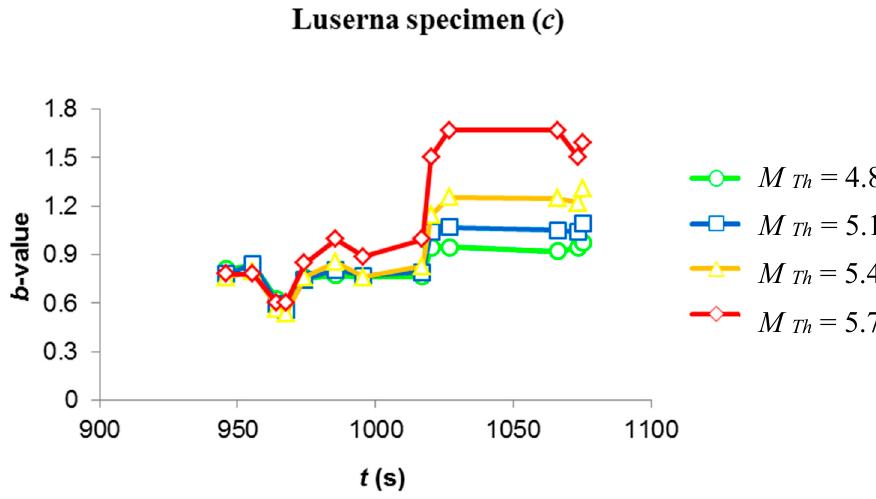
Figure 9. Trend of b-values for different threshold magnitudes. Trend lines of specimen ( c ) (upper panel) appear more self-similar than specimen ( d ) (lower panel). 6. Conclusions The present work focused on simultaneously acquired AE and electrical resistance time series, recorded during loading tests conducted on cement mortar (CM) and Luserna stone (LS) specimens. It was observed a brittle mechanical response from CM specimens wherein, despite the absence of significant deviations from linear elasticity, the increase in electrical resistance and AE activity during the approach to failure revealed accumulation damage. On the contrary, except for the case ( d ), LS specimens were characterized by a more ductile behavior, with numerous intermediate load drops correlated to clusters of AE events and changes in electrical resistance. These differences are reflected by the NT analysis of the recorded AE and electrical resistance time series, where electrical properties systematically reach criticality earlier than AE: the LS–AE criticality is reached in correspondence with significantly increased AE activity, and in correspondence with abrupt stress drops, whereas LS–electrical criticality can precede the major increments in the electrical resistance. The CM–AE criticality is reached at the onset of the